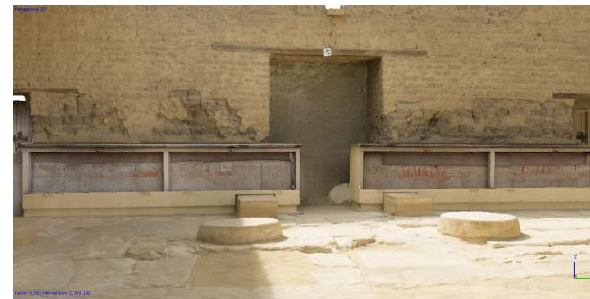
Figure 7. Same view of the 3D model of the tomb of Maya after the digital removal of the wooden lockers (elaboration by F. Fiorillo,